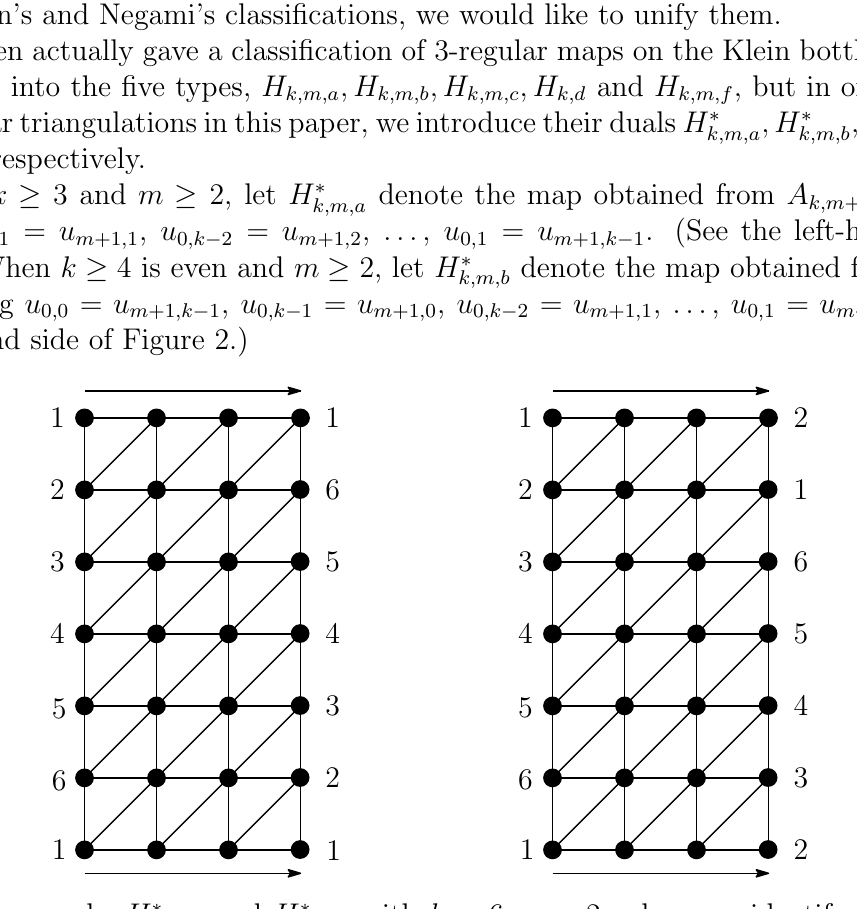
and H (cid:3) with k = 6 ; m = 2, where we identify the vertices k;m;a k;m;b